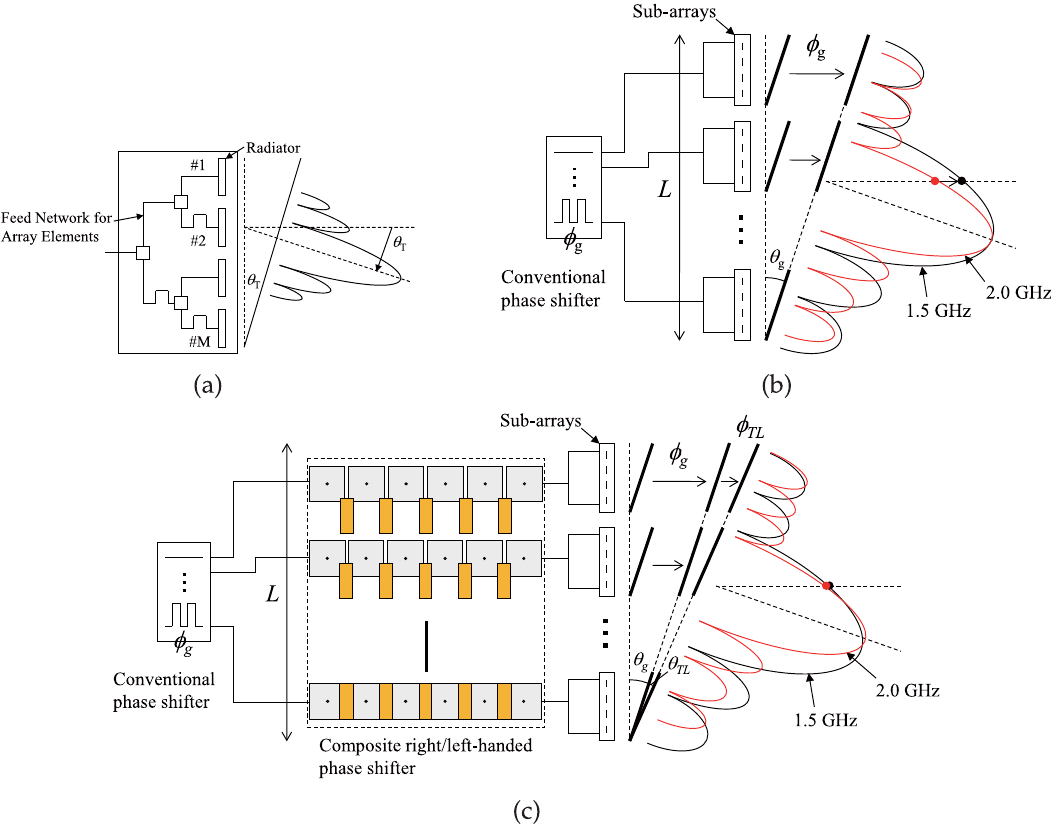
Fig. 1. Con fi guration concept of base station antenna. (a) Sub-array composed of 4 array elements. (b) Base station antenna with conventional phase shifter and (c) proposed conposite right/left-handed phase shifter.